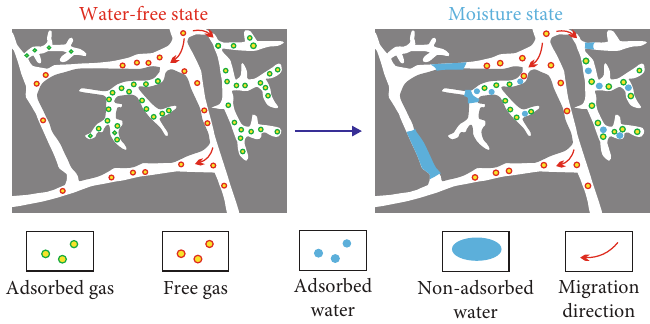
Figure 7: In fl uence of water locking e ff ect on adsorption/desorption characteristics of methane in coal (modi fi ed from literature